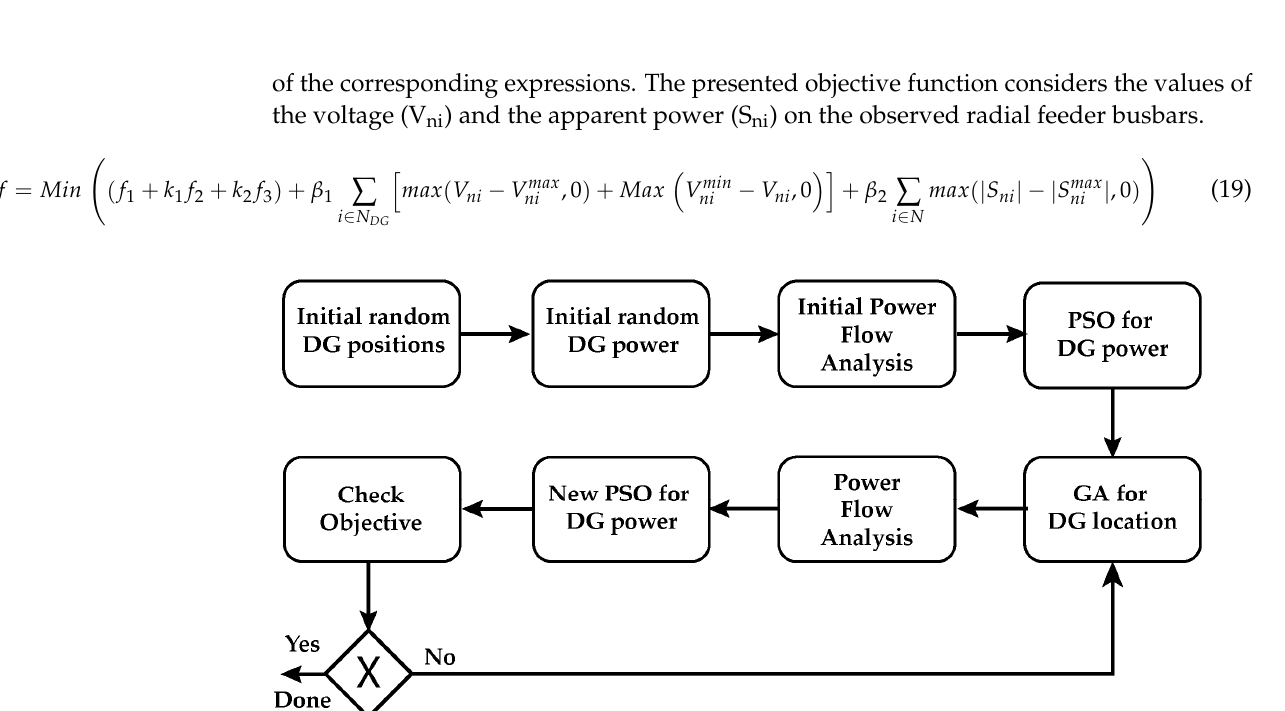
Interestingly, the authors examined three separate cases, one with PSO only, one with